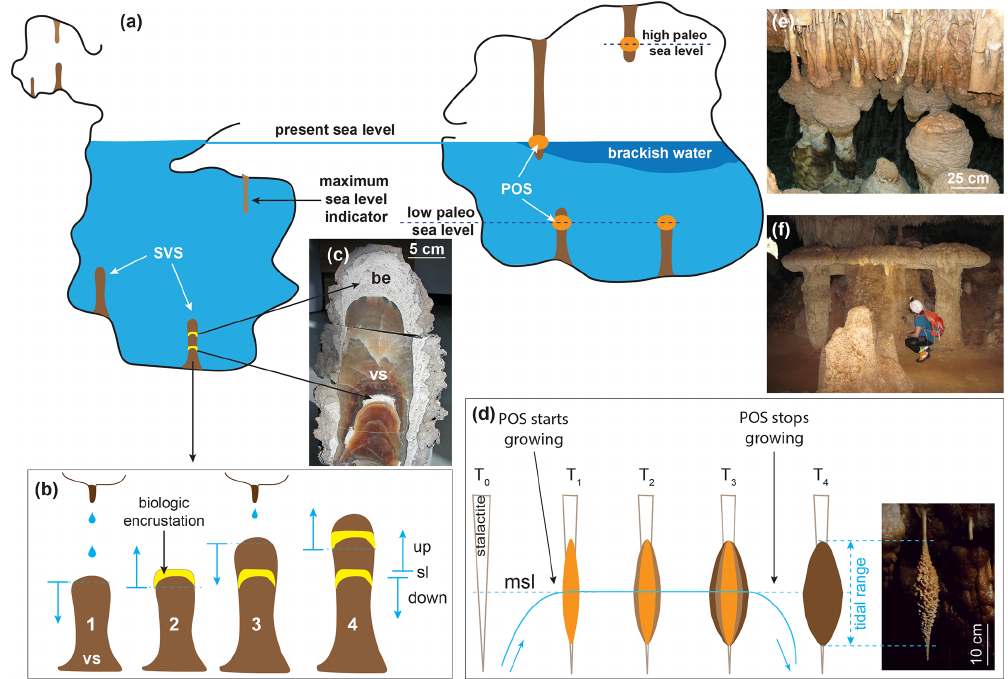
Figure 1. (a) Composite diagram showing how submerged vadose speleothems (on the left) and phreatic overgrowths on speleothems (on the right) in littoral caves act as sea-level indicators. (b) Conceptual model showing that (b1) growth of SVSs indicates times when sea level was lower than their elevation; (b2) Hiatus – period of SVS submergence suggesting sea level higher than the SVS elevation; (b3) SVSs resume their deposition when sea level fell below its elevation. (c) SVS (be: biogenic encrustation; vs: vadose speleothem) from Argentarola Cave, Italy (photo courtesy Fabrizio Antonioli). (d) Conceptual models showing how POSs form; as long as sea level remains at the same elevation (T1–T3) POSs will precipitate at sea level and within tidal range and will continue to grow until the sea level drops below the speleothem (T4). (e) Late Holocene POS in Cala Varques Cave, Majorca. (f) Mushroom-shaped POS in Santa Catalina Cave, Cuba (photo courtesy Bogdan P.